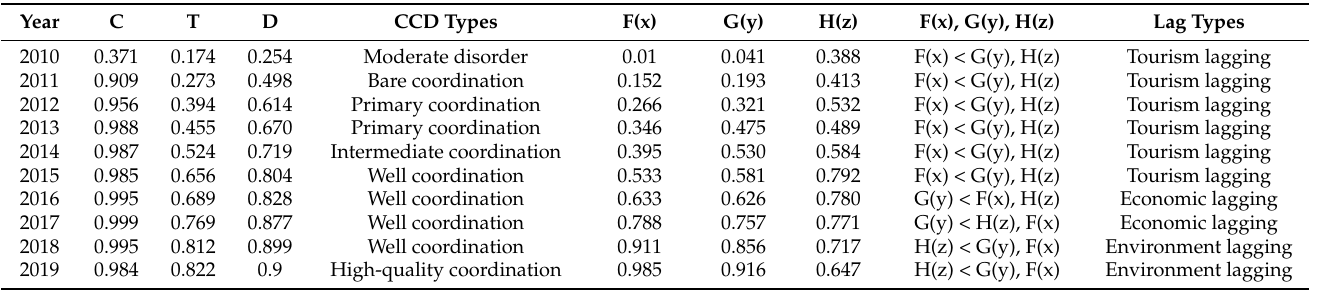
Table 4. Comprehensive evaluation values and classification types of CCD of the TEE system in the